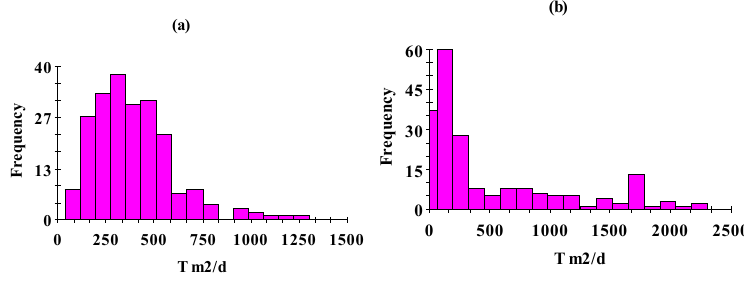
Figure 4. Histogram plots of the transmissivity of the Kg ( a ) and Dm ( b ) aquifers.